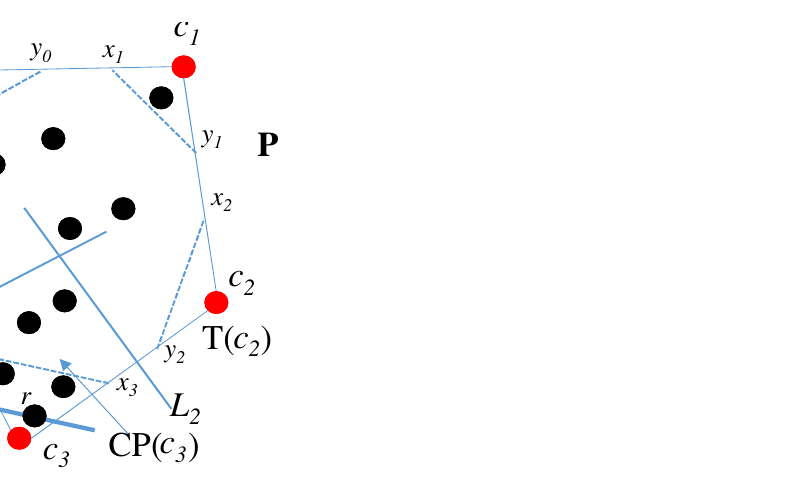
Figure 2. Example of corner triangle, corner line segment, triangle line segment, and corner polygon.